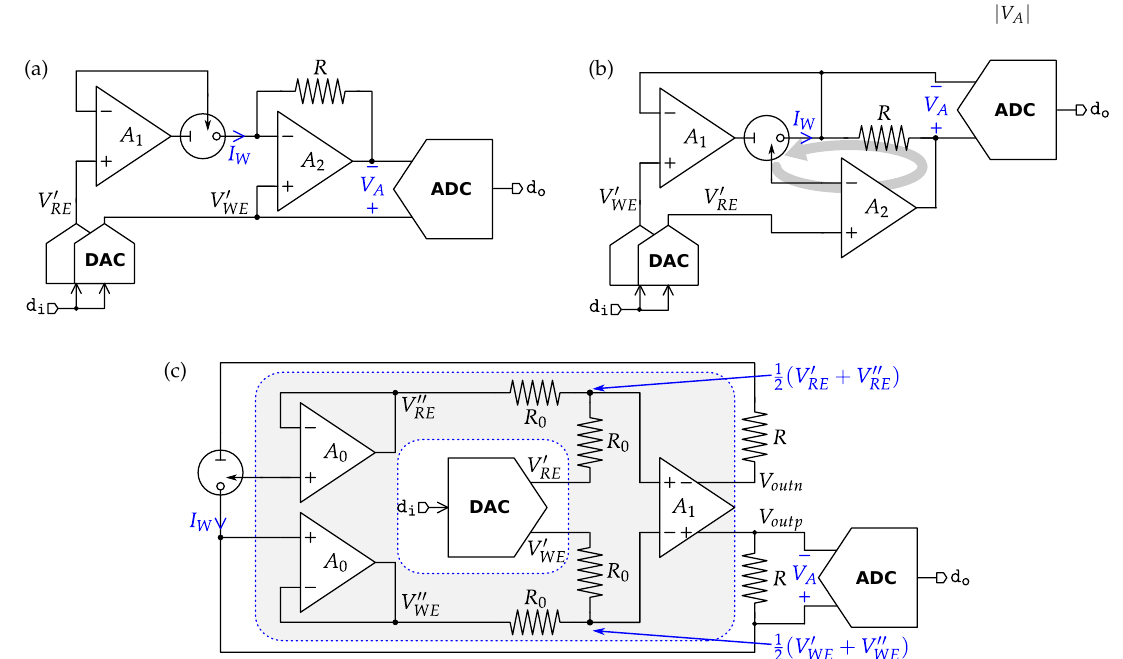
Figure 10. Potentiostatic interfaces based on continuous time I -to- V conversion ( a ) conventional solution; ( b ) sensor-in-the-loop solution; ( c ) fully-differential